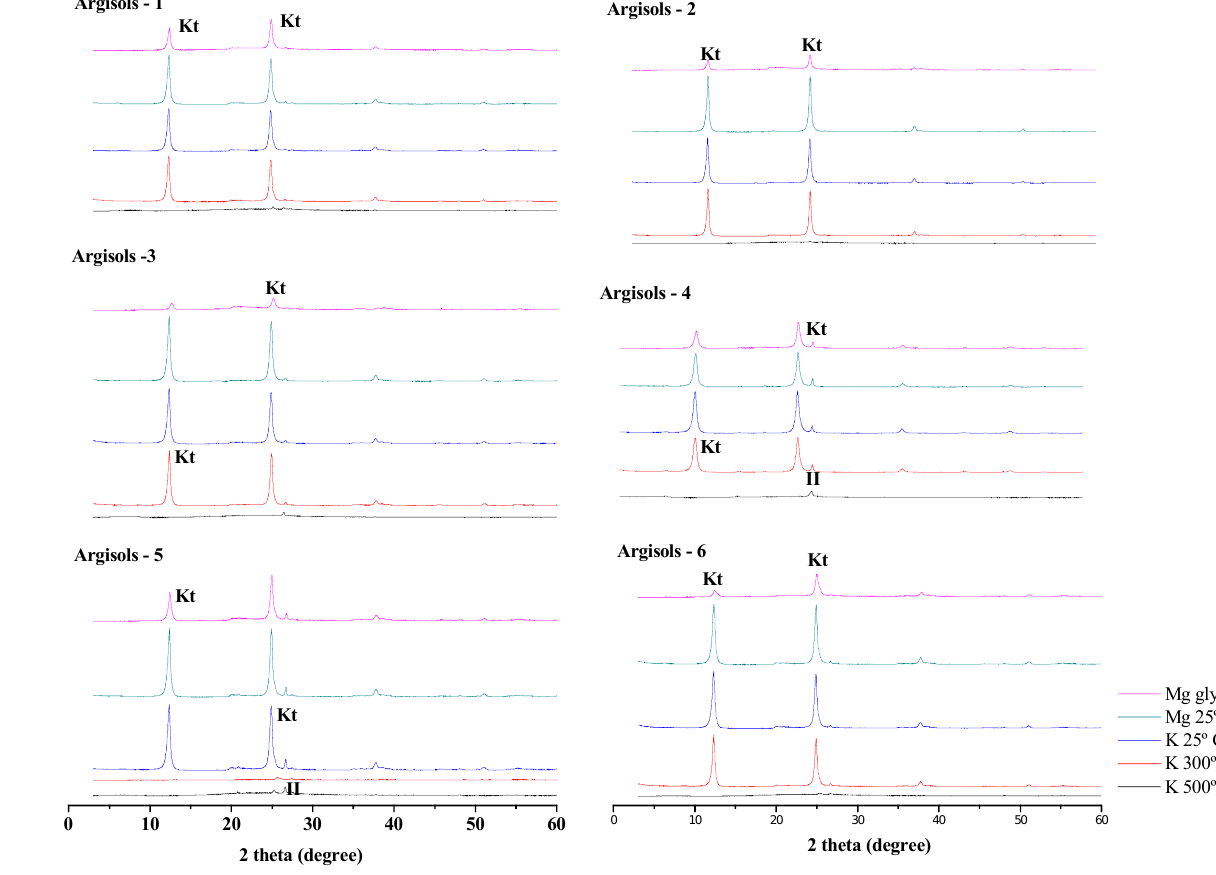
Figure 8. X-ray diffractograms in Argisols of the state of